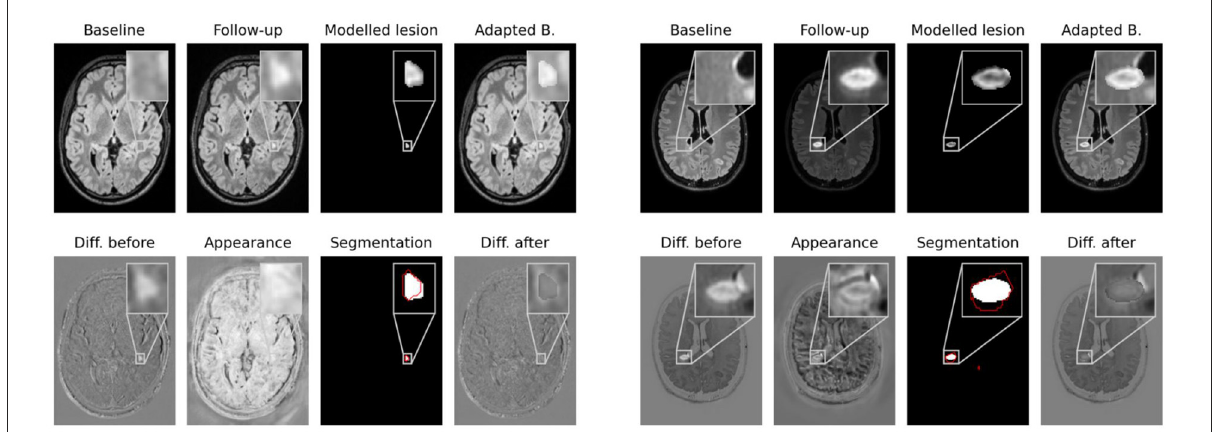
FIGURE4 Modeling of new lesions. The appearance map is masked with the new lesions segmentation and added to the spatially deformed baseline image. The upper row shows baseline and follow-up images, the masked appearance map, deformed and appearance adapted baseline. In the lower row the difference image between follow-up and baseline, the appearance map, the segmentation of our CNN and the difference image between follow-up and adapted baseline are shown. The ground truth lesion segmentation is overlaid in red onto the network’s